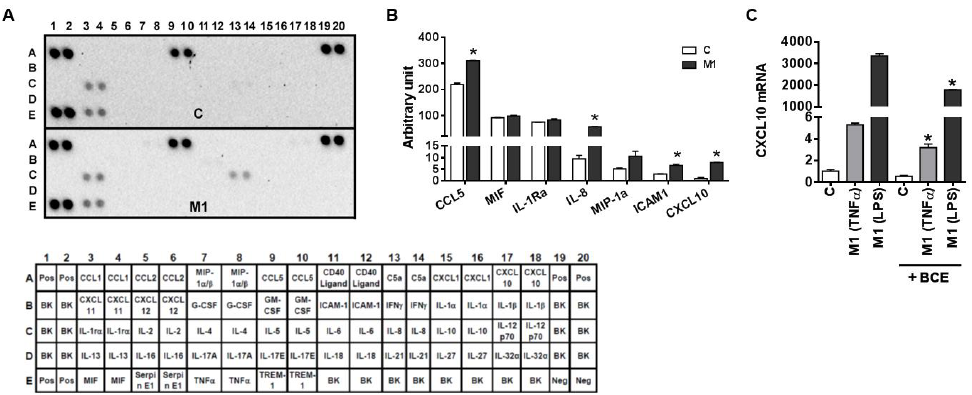
Figure 3. Characterization of cytokine secretion in human THP-1 macrophages. THP-1 monocytes were differentiated into macrophages in the presence of phorbol 12-myristate 13-acetate (PMA, 10 ng/mL) for 24 h. Subsequently, cells were incubated in regular growth medium without PMA for 24 h for resting, after which they were polarized into M1 using interferon γ (IFNγ) and tumor necrosis factor α (TNFα) or IFNγ and lipopolysaccharide (LPS) (25 ng/mL each). ( A ) Human cytokine array. Cell culture media from control (C, not treated with cytokines) or M1 macrophages (IFNγ and TNFα) were used to detect cytokines secreted from cells using a human cytokine array. Cytokine array layout is shown in the bottom. ( B ) Quantification of cytokines from the cytokine array. The intensity for each cytokine was normalized by positive controls for each blot. *, p < 0.05 vs. control. ( C ) The expression of C-X-C motif ligand 10 (CXCL10) in polarized THP-1 macrophages. Blackcurrant extract (BCE, 50 µg/mL) or control was treated during 24 h of polarization. Data are shown as mean ± SEM. *, p < 0.05 vs. respective no BCE control.